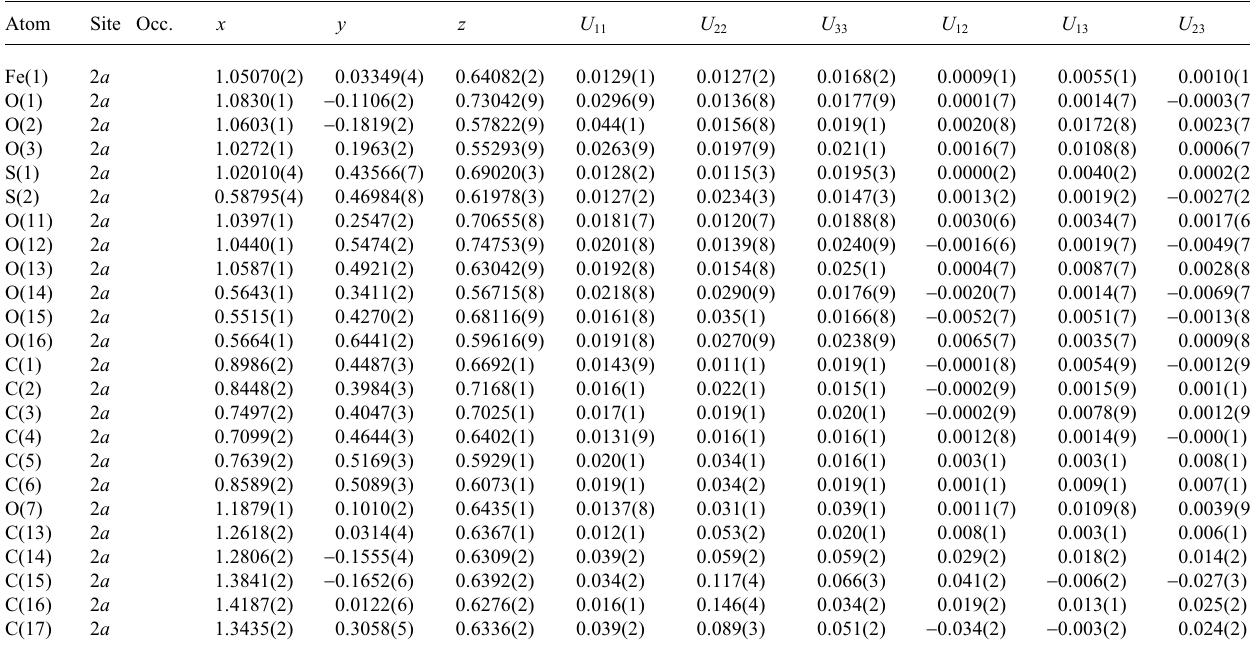
Table 3. Atomic coordinates and displacement parameters (in Å 2 )